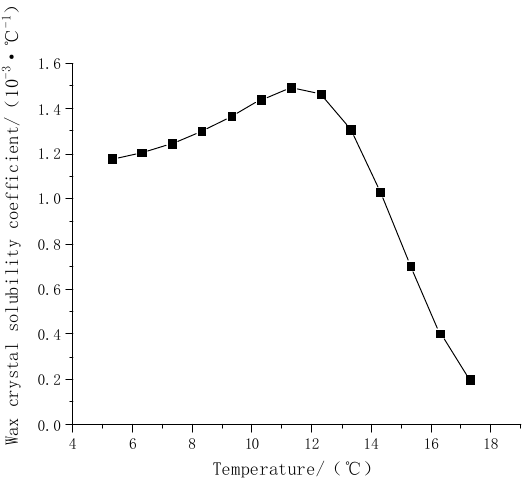
Figure 3. Wax precipitation curve of Shunbei crude oil. The chemical composition results of the Shunbei crude oil samples were analyzed by gas chromatography-mass spectrometry, and the carbon number distribution results of the crude oil were sorted out as shown in Figure